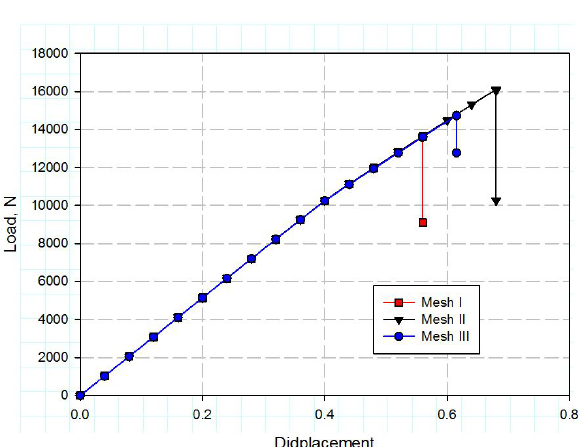
Fig. 4. Stress Strain diagram of different mesh size.